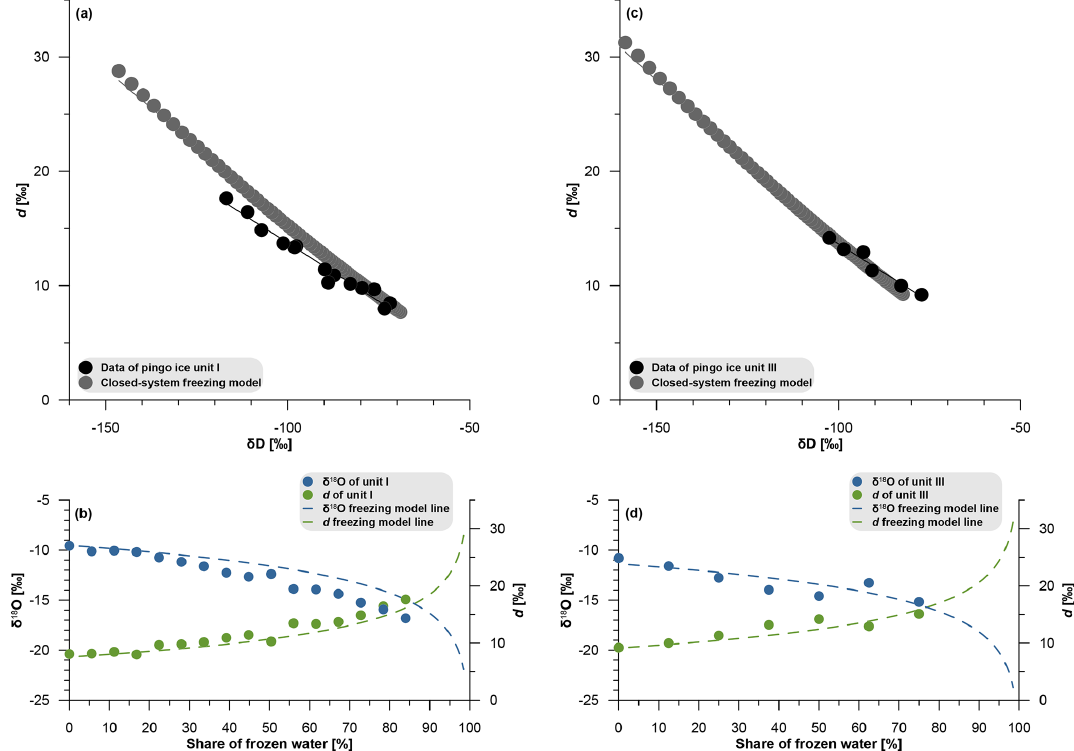
Figure 5. Isotopic composition of unit I (a, b) and unit III (c, d) of the massive pingo ice of core 9 in comparison to freezing model data under closed-system conditions (Ekaykin et al.,